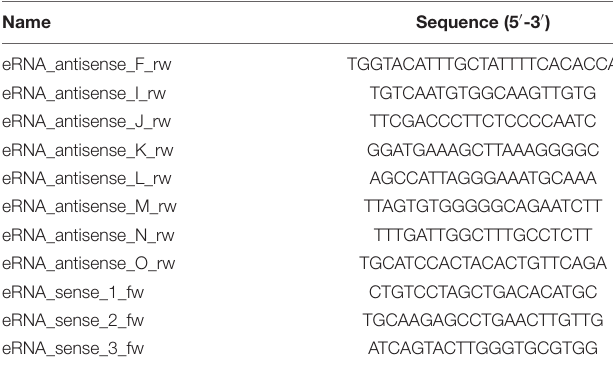
TABLE 6 | Primers sequences used for the analysis of sense and antisense eRNA 3 (cid:48)